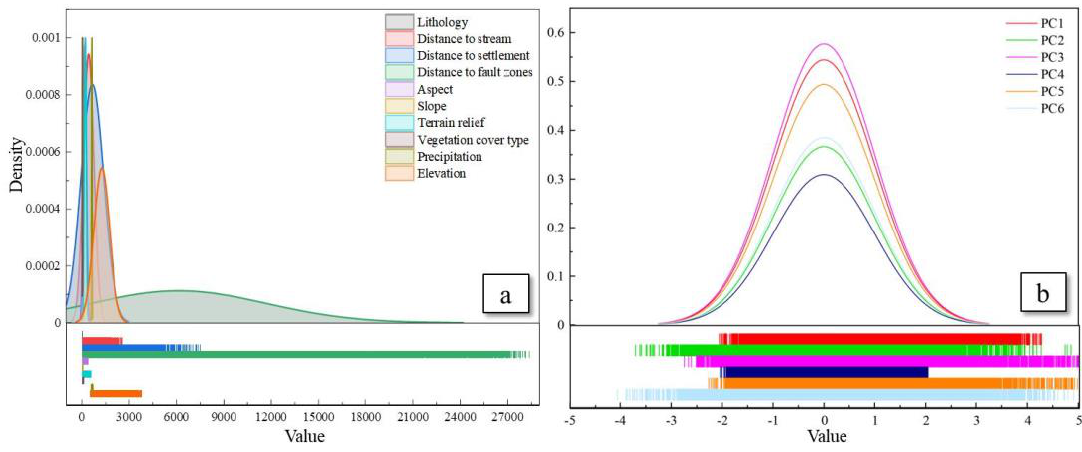
Figure 8. Normal distribution and axial-whisker plots: ( a ) LCFs; ( b ) PCs.